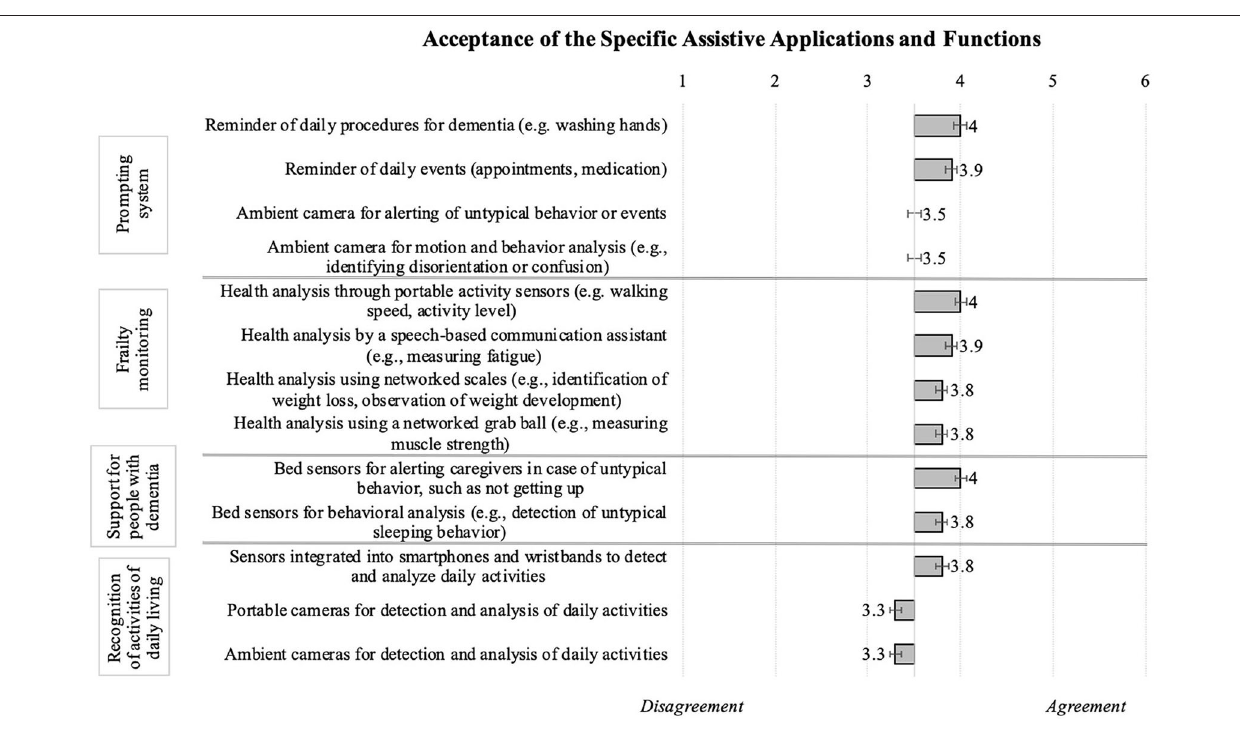
FIGURE 8 | Technology acceptance of specific health-related applications and functions ( N =